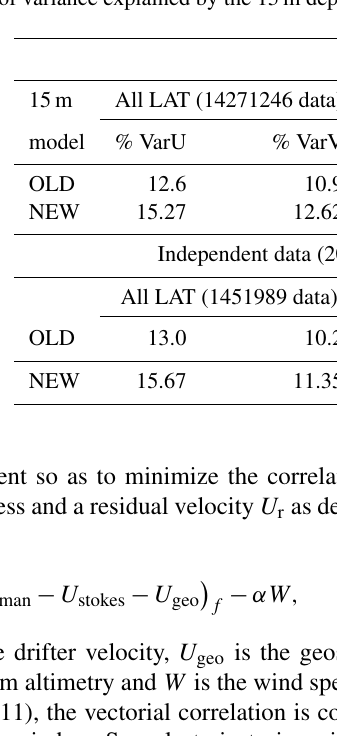
Table 2. Percentage of variance explained by the 15m depth wind-driven